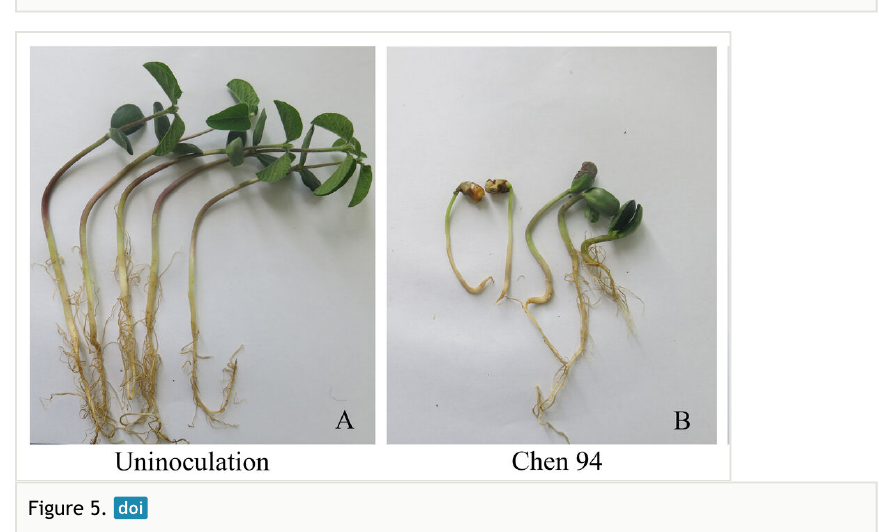
Figure 5. Pathogenicity of Pythium huanghuaiense (Chen 94) on the soybean cultivar Hefeng 47. A. Control; B. disease symptoms caused by P. huanghuaiense